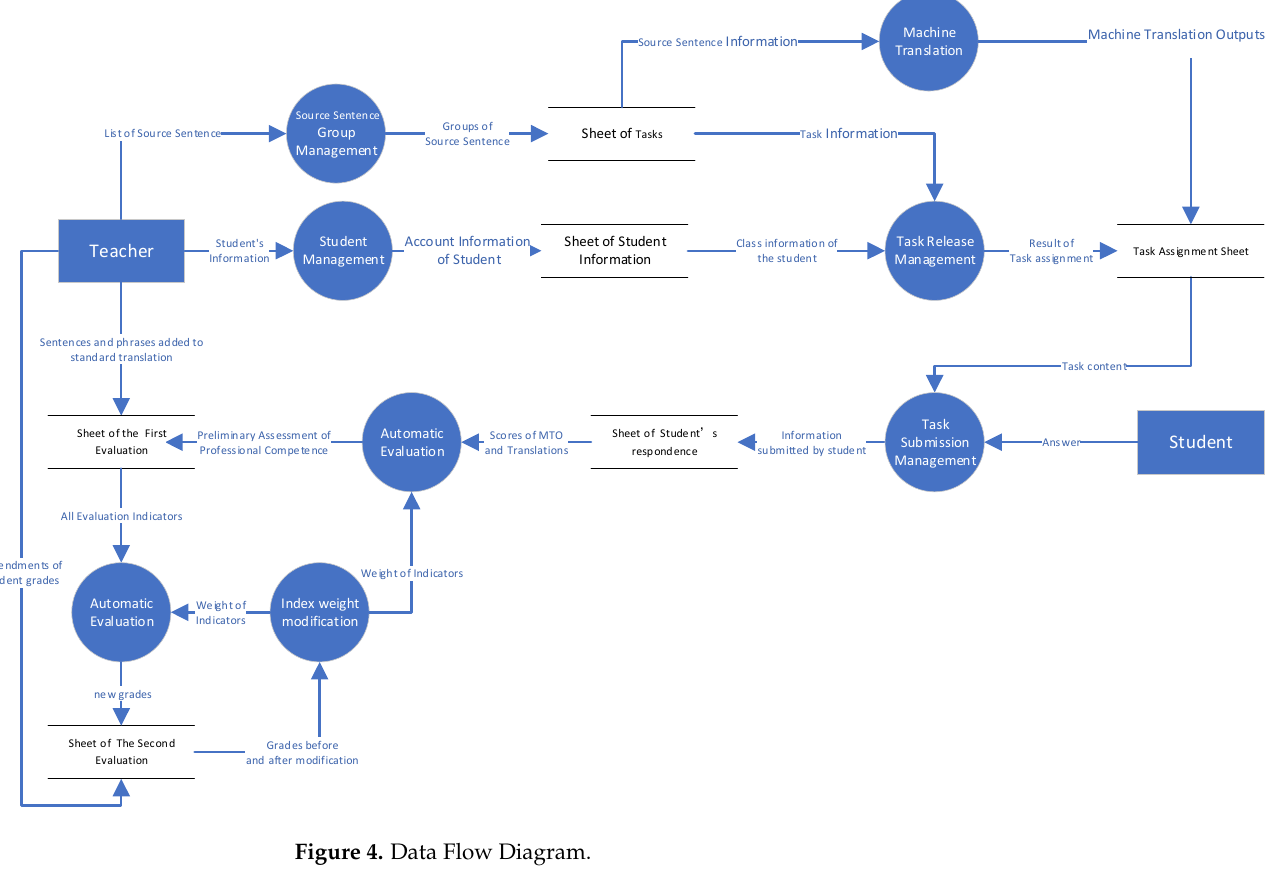
Figure 4. Data Flow Diagram.